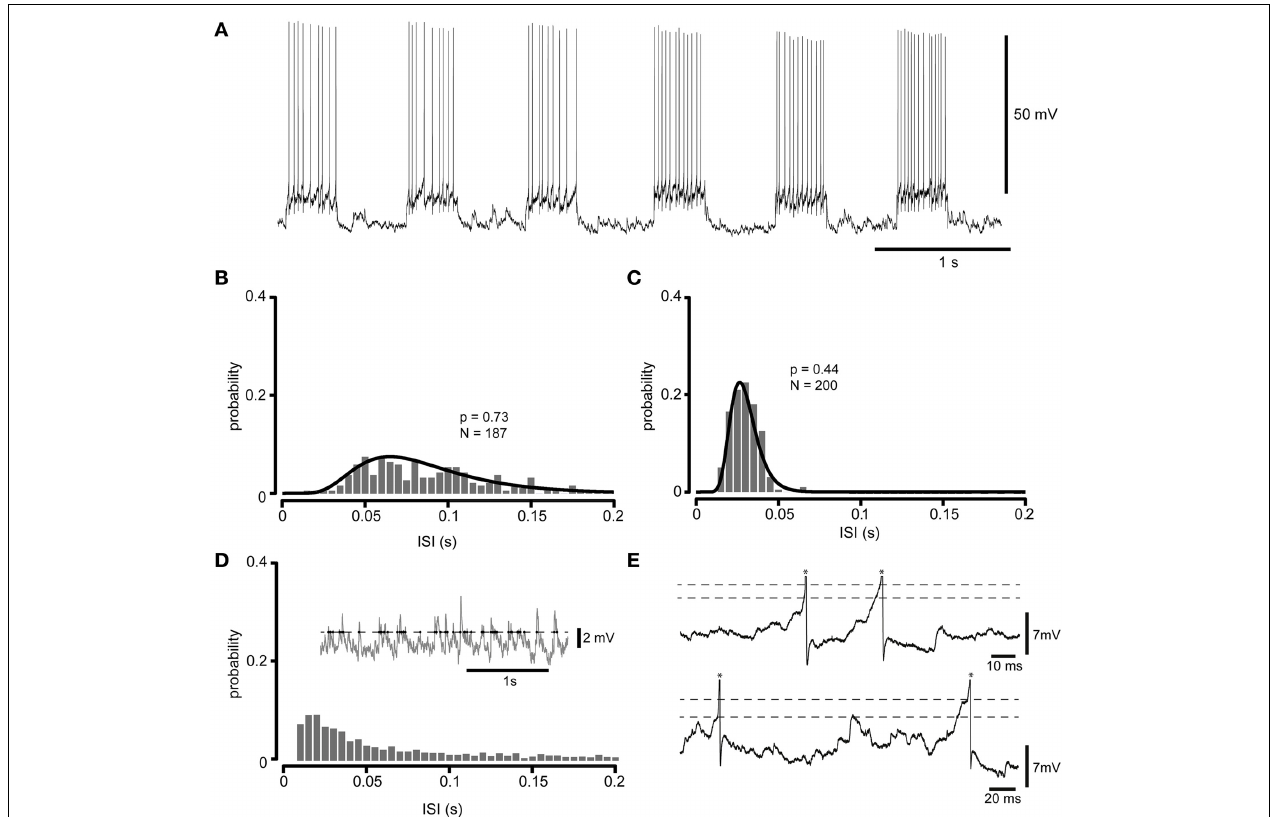
subsequent 2nd order Butterworth low-pass filter with a cutoff frequency of 1000Hz; ISIs below 10ms, which was not observed in this neuron (cf. C ),